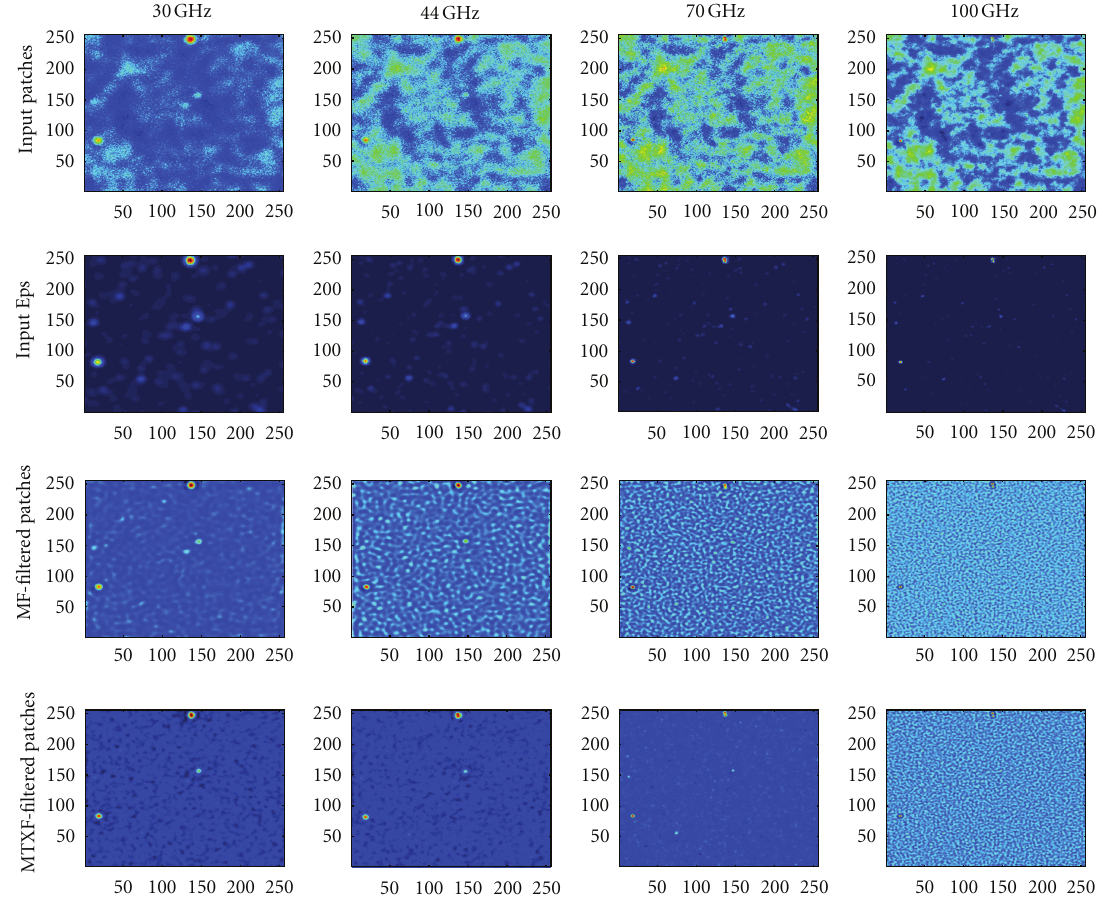
Figure 1: Comparison between single-channel-matched filtering and multichannel MTXF filtering for a four-channel simulation of a patch of the sky as observed by the Planck 30, 44, 70 and 100 GHz detectors. The top row of images show the simulated patches. The second row shows just the point sources present in the simulations. The third row shows the patches after being filtered with single-channel-matched filters. The fourth row shows the patches filtered with the corresponding MTXF. The x -and y -axes are in pixel units (pixel size = 3.435